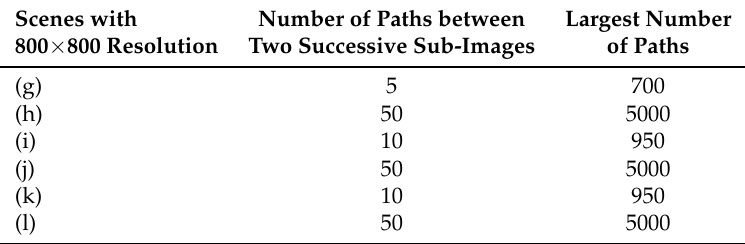
Table 1. Number of paths per pixel between two successive sub-images and largest number of paths per pixel for the scenes with 800 × 800